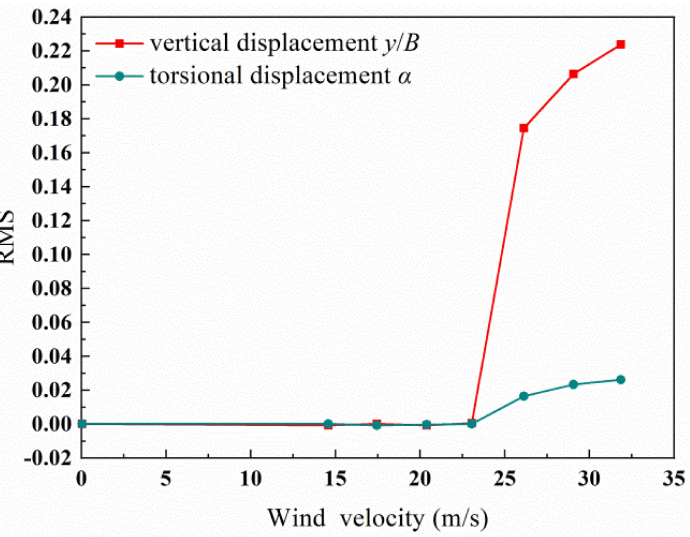
Figure 10. Nondimensionalized RMS displacements of the wind-retaining plate section, − 5 ◦ angle of attack.